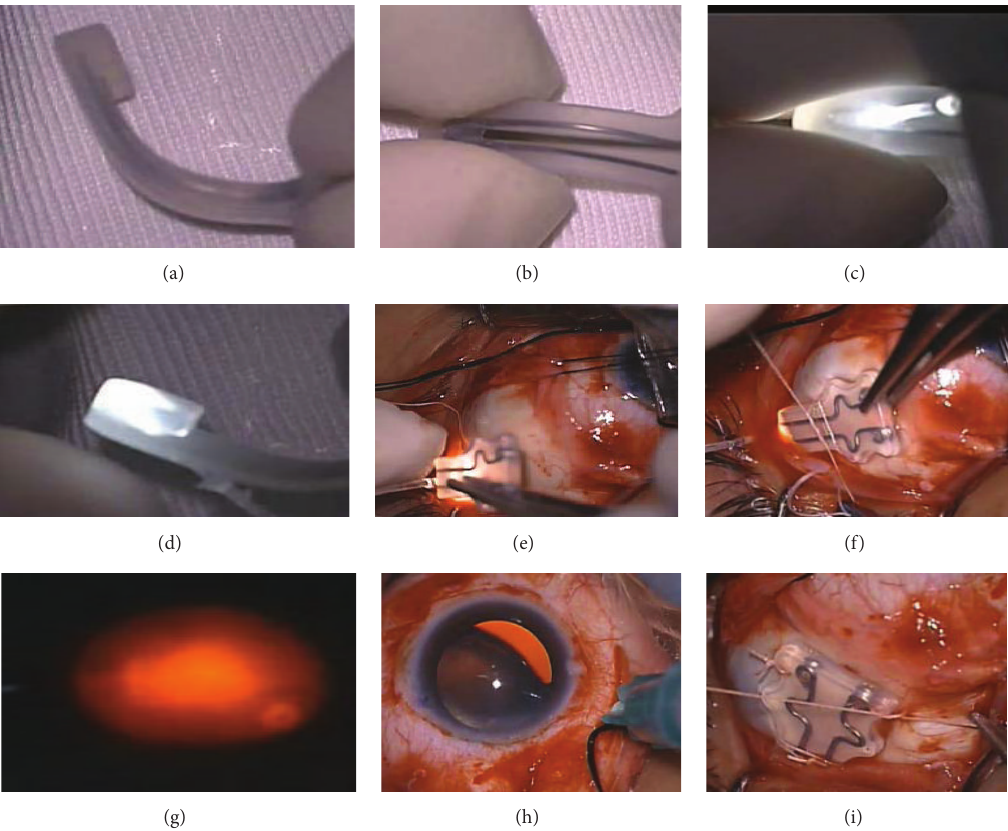
Figure 1: Surgical procedure. (a) Partially bending the Ando plombe to get the desired indentation. (b) A 23-gauge needle inserted towards the indenting head of the explant. (c) A disposable Chandelier fiber (27-gauge) was inserted toward the center of the heel. (d) The terminal knob is illuminated. (e) Placement of the buckle guided with anatomical landmarks. (f) Temporary sutures were taken 18 mm from the limbus betweensuperiorandinferiorobliquemuscleinsertions7 mmaparttokeeptheAndoplombefromrotating.(g)Theglowingheadprogression could be seen easily owing to the strong illumination of the fiber optic light. (h) Intravitreal air injected to adjust the IOP. (i) The plombe is then secured in